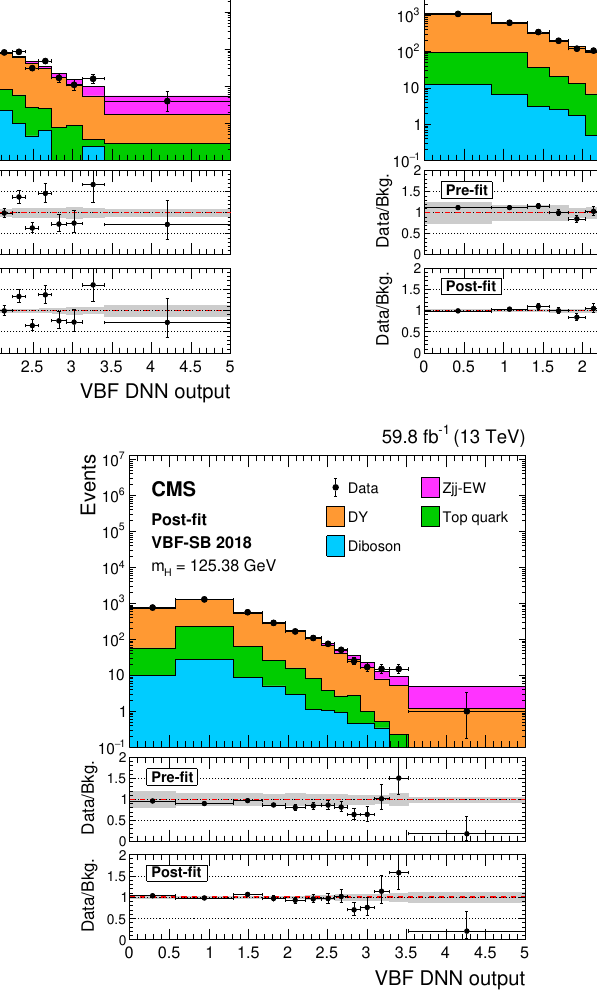
Figure 2 . The observed DNN output distribution for data collected in 2016 (first row, upper), 2017 (first row, lower), and 2018 (second row) in the VBF-SB region compared to the post-fit background estimate from SM processes. The predicted backgrounds are obtained from a S+B fit performed across analysis regions and years. The description of the three panels is the same as in figure